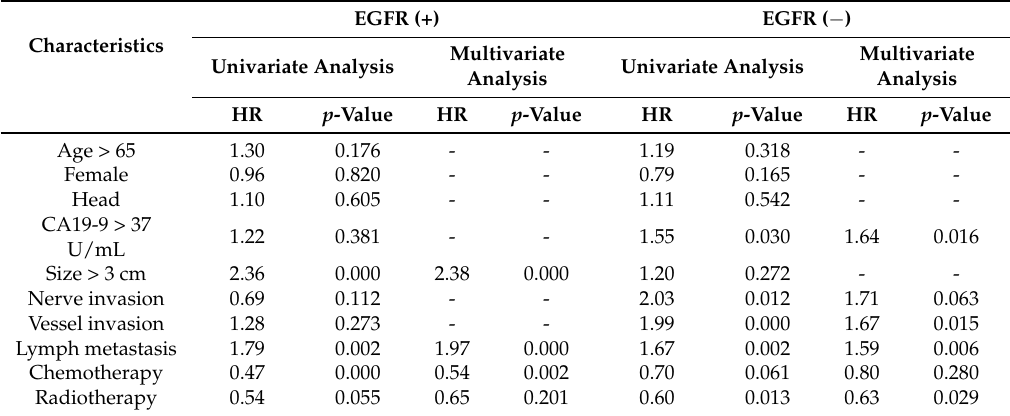
Table 3. Hazard ratios (HR) and p -value for death associated with demographic and prognostic factors stratified by EGFR expression using univariate and multivariate analyses.